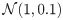
The Kuramoto order parameter as a function of number of microelectrodes and the strength of the control.Left panel: for each couple (M, γ/4) ∈ [5, 50] × [2, 10] we numerically simulate the controlled system (12) involving N = 100 oscillators interconnected using an all-to-all topology, with coupling parameter K = 0.5 and frequencies ωi drawn from a normal distribution N(1,0.1). Each point is the average over 50 independent realisations (different initial conditions but same frequencies). Right panel: a different visualisation of 〈R〉 allowing to emphasise the relation γr(M), r = 0.8 (dashed curve), r = 0.4 (dotted curve) and r = 0.1 (solid curve); let us stress that the latter curves have been draw with a visual guide scope and have not been analytically determined.